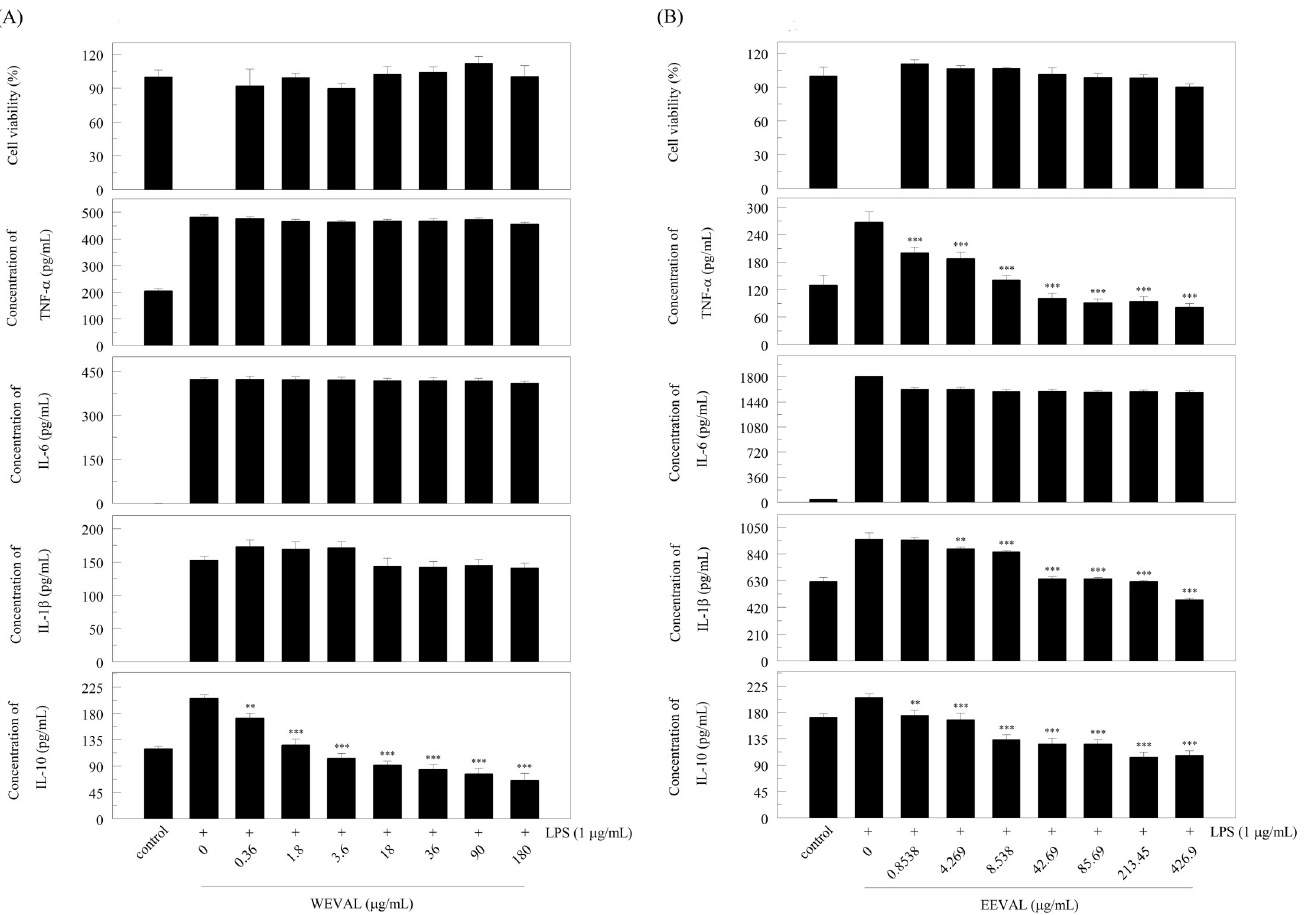
Fig 2. Effects of the VA leaf extracts on RAW 264.7 cell viability and on cytokine production in LPS-stimulated macrophages. Effect of (A) WEVAL and (B) EEVAL on cell viability and TNF- α , IL-6, IL-1 β , and IL-10 production. Results are expressed as mean ± SD of triplicate experiments. Statistically significant changes were clustered as more significant ( �� ) where p < 0.01 and highly significant ( ��� ) where p < 0.001 as compared with LPS-stimulated